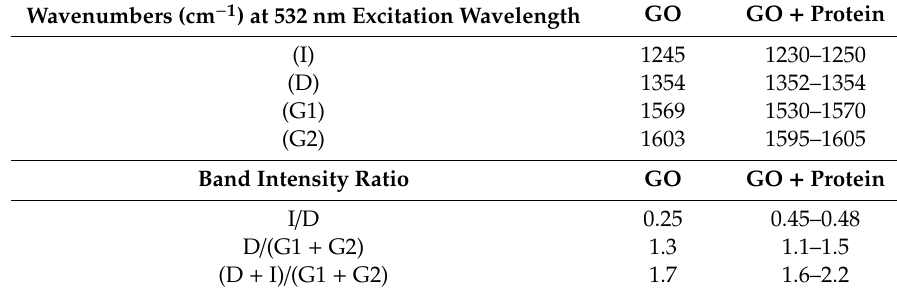
Table 1. Raman spectroscopy data from the GO and protein-coated GO nanoparticles (proteins = BSA, collagen or elastin).